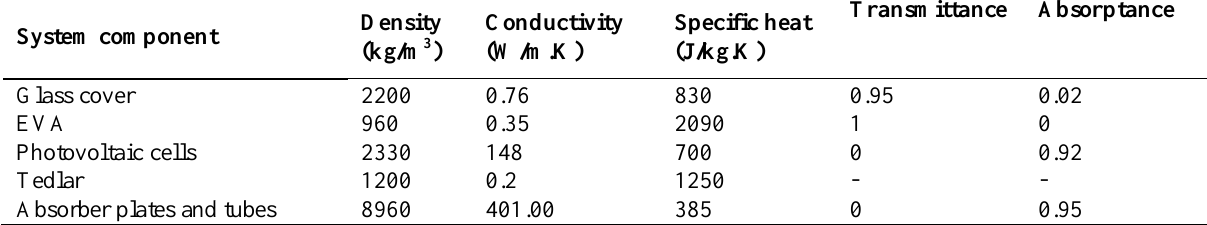
Thermophysical and radiation properties of the different elements [4, 12]. System